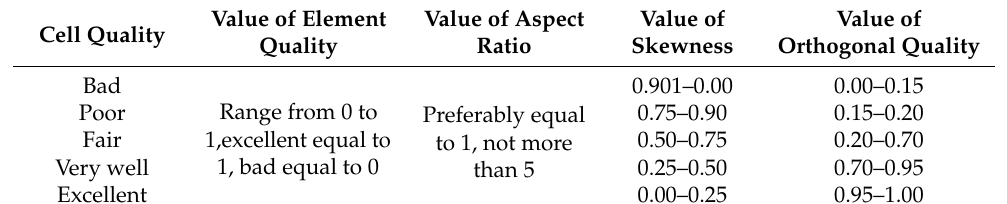
Table 3. Grid quality evaluation criteria.